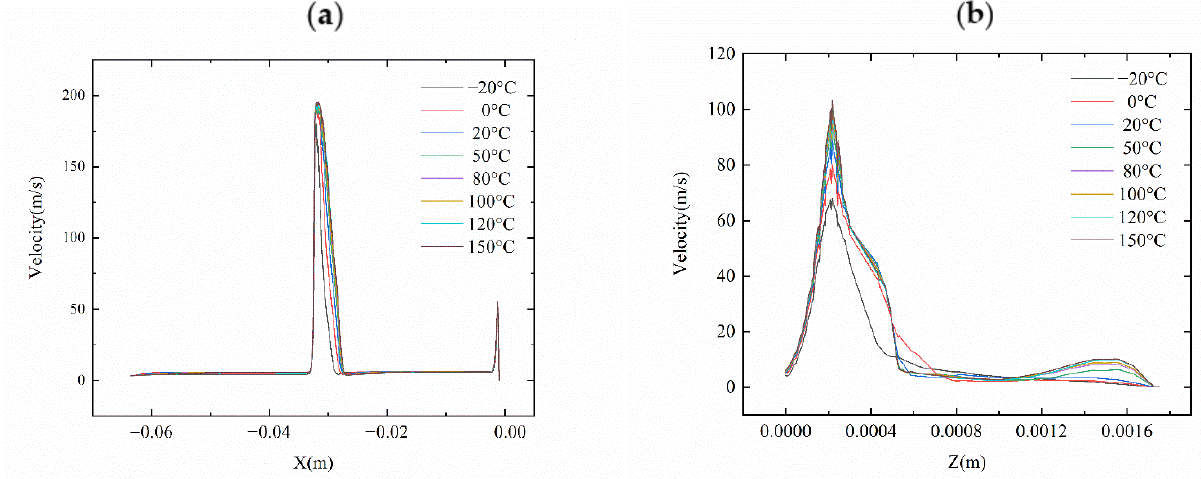
Figure 13. Velocity distribution. ( a ) Axial velocity distribution at the centerline of AI section; ( b ) Z-directional velocity distribution at XZ section